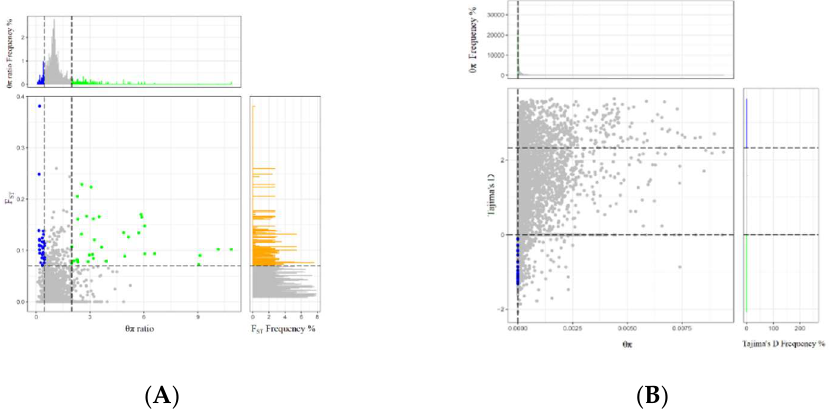
Figure 2. Intersection of the joint analysis used to identify selection regions. ( A ) Distribution of θπ ratios (θπ, single colt group /θπ, twin colt group) and F ST values, which are calculated in 100 kb windows and sliding in 10 kb steps. Data above the horizontal dashed line (where F ST is 0.0729208) were identified as selected regions for single colt group (blue points) and twin colt group (green points), respectively; ( B ) Distribution of θπ and Tajima’s D. Selection was taken by a 5% threshold, with blue and green dots as candidate